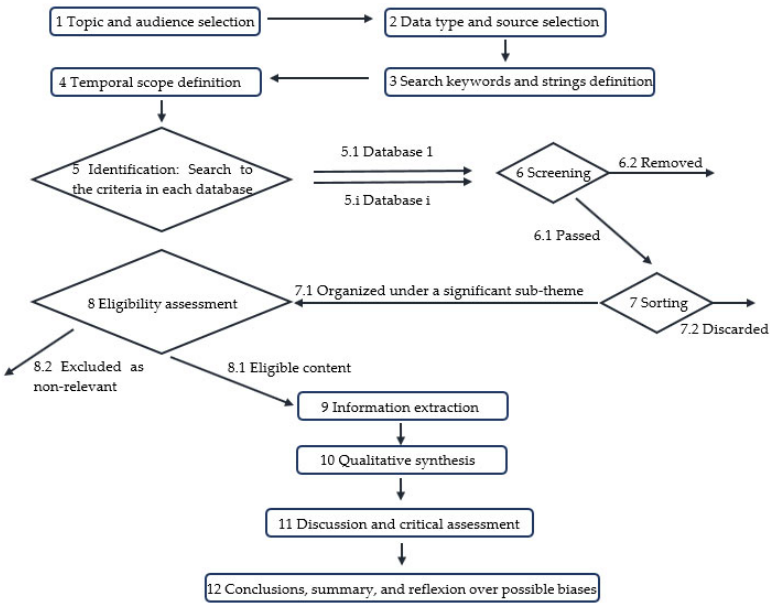
Figure 1. Search and systematic review methodology [35].